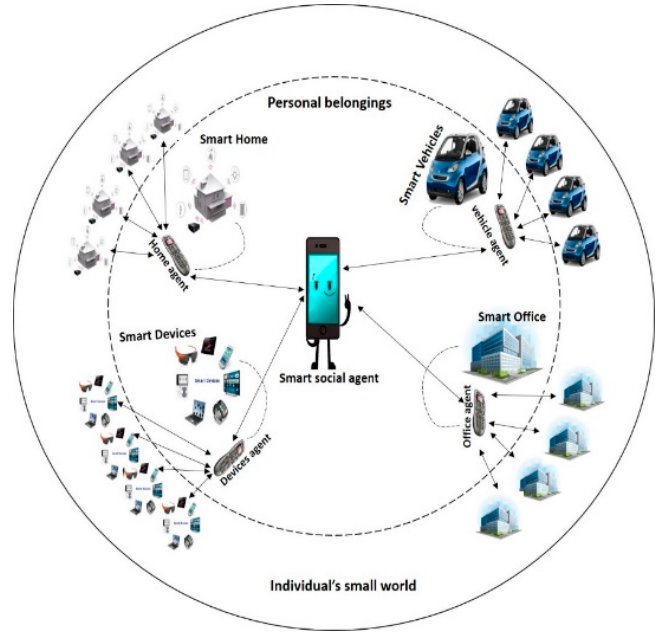
Figure 1. The small world of Social Internet of Things (SIoT) Smart Devices.